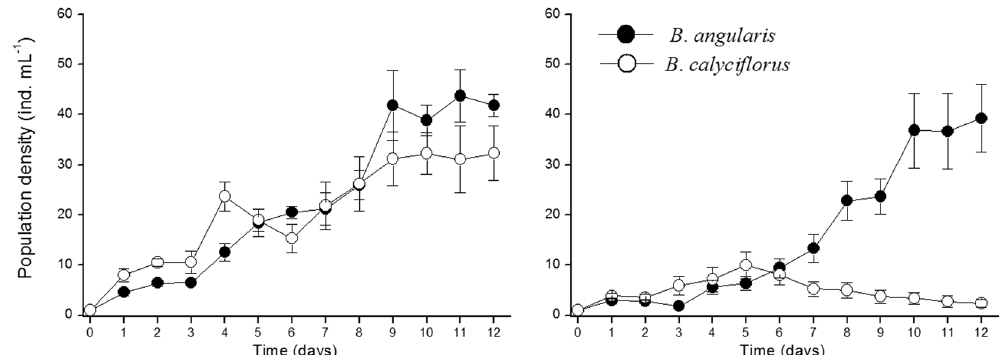
Figure 5. Population dynamics of Brachionus angularis ( B . a .) and Brachionus calyciflorus ( B . c .) fed with Chlorella pyrenoidosa at a concentration of 1 mg C L − 1 . Left: B . a . and B . c . were co-cultured without predator. Right: B . a . and B . c . were co-cultured under predation risk ( Asplanchna brightwellii = 100 ind. L − 1 ). Data shown are mean ± standard error values based on six